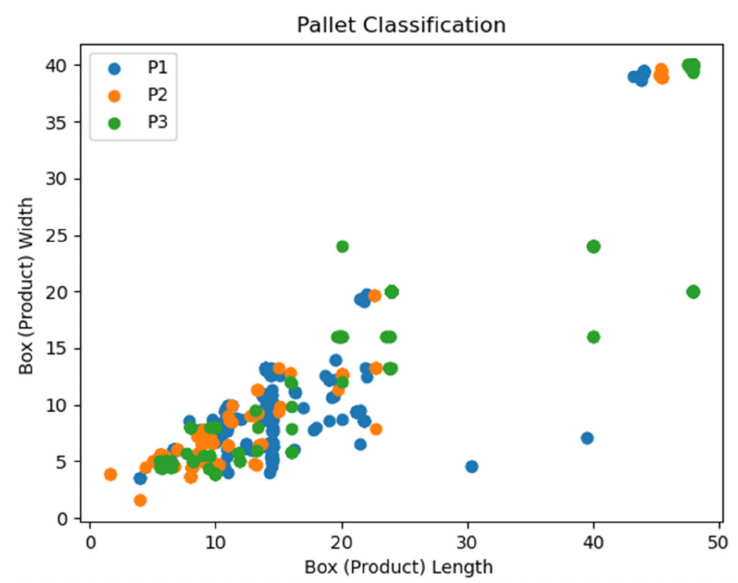
Figure 6. Distribution of the 1K data points according to class.